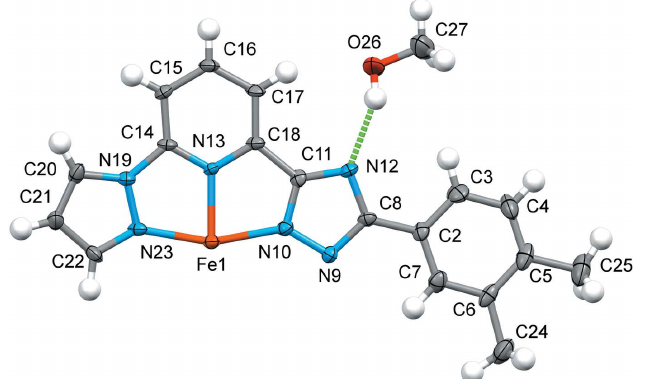
Figure 1 The molecular structure of half the title compound as refined in the asymmetric unit with displacement ellipsoids drawn at the 50% probability level. The O—H (cid:2)(cid:2)(cid:2) N hydrogen bond is indicated by the dashed line. This and the next figure were generated with the program Mercury (Macrae et al. , 2020).